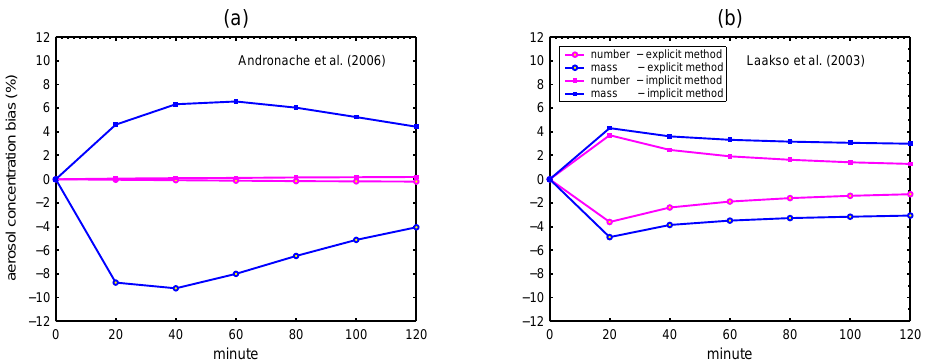
Fig. 11. Percentage bias from using an integration time step of 20min relative to the results obtained using a time step of 10s. Two different size-resolved 3 parameterizations, one theoretical (Andronache et al., 2006) and one empirical (Laakso et al., 2003), were considered. Rainfall intensity R was chosen to be 1mmh − 1 . Results are shown for both explicit (solid lines) and implicit (dashed lines) time integration